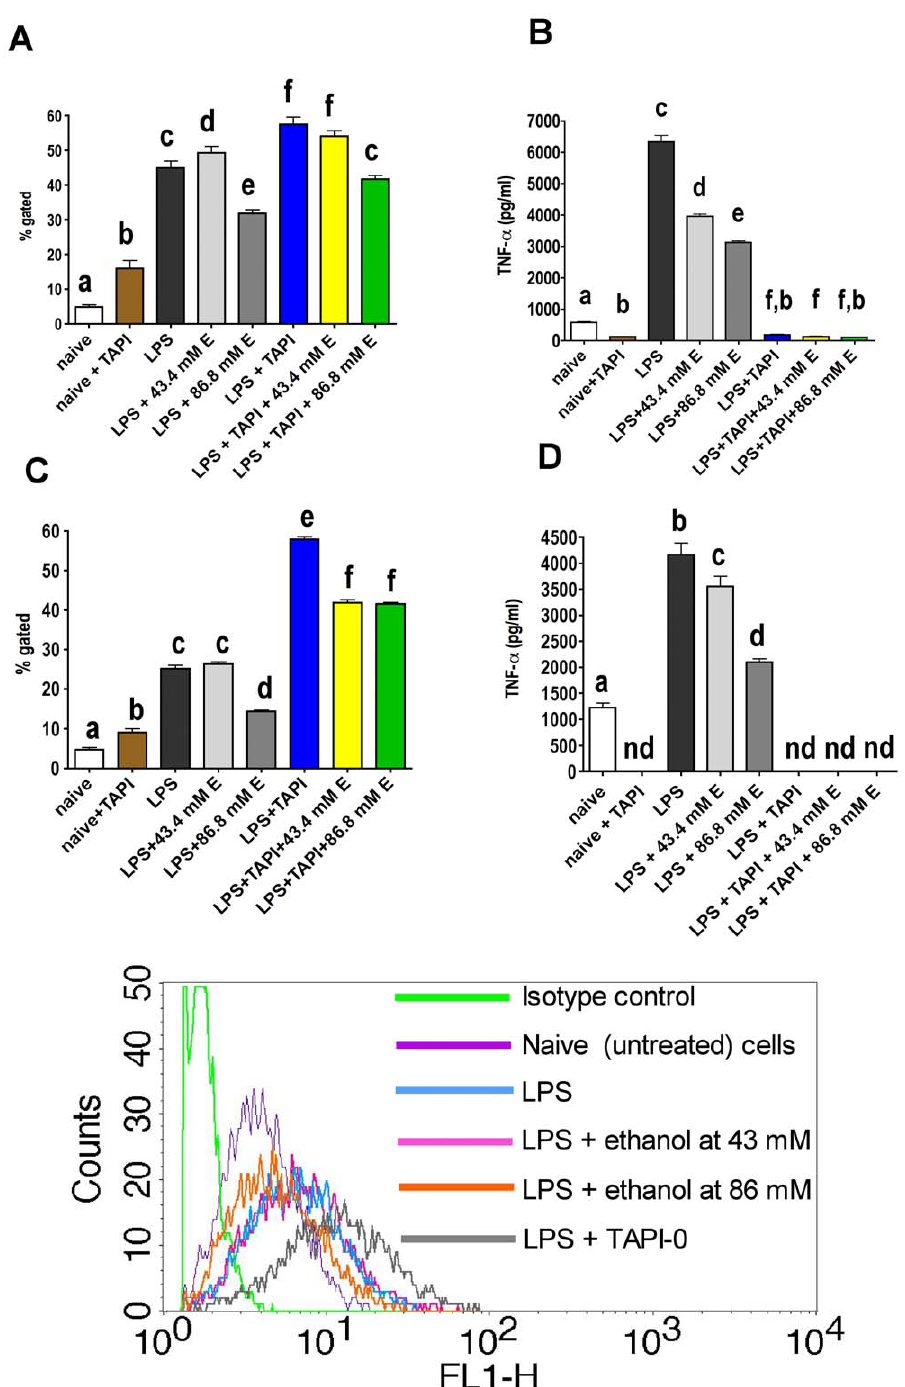
Figure 5. Surface expression of TNF- a on RAW264.7 cells measured by flow cytometry, and TNF- a ELISA from cell culture supernatants of the same experiments. Results shown in A and B were obtained in one experiment and results shown in C and D were obtained in an independent experiment. In some groups, no TNF- a was detected (nd). Each group contained 5 samples. Two repeat experiments are shown. Cells were treated with ethanol (either 43.4 mM or 86.8 mM), 100 ng/ml LPS or 20 m g/ml TAPI-0, or a combination of these treatments. ELISA was performed from cell culture supernatants of each group. The percentage of gated cells (positive for TNF- a surface expression by flow cytometry) for each group is shown in A & C . The ELISA results from cell culture supernatants of the cells used for flow cytometry are depicted in B and D . Bars designated by the same letter are not significantly different (p . 0.05); bars with no shared letters are significantly different (p , 0.05). Histograms for representative samples from key groups for the experiment shown in A are shown below panels C and D .